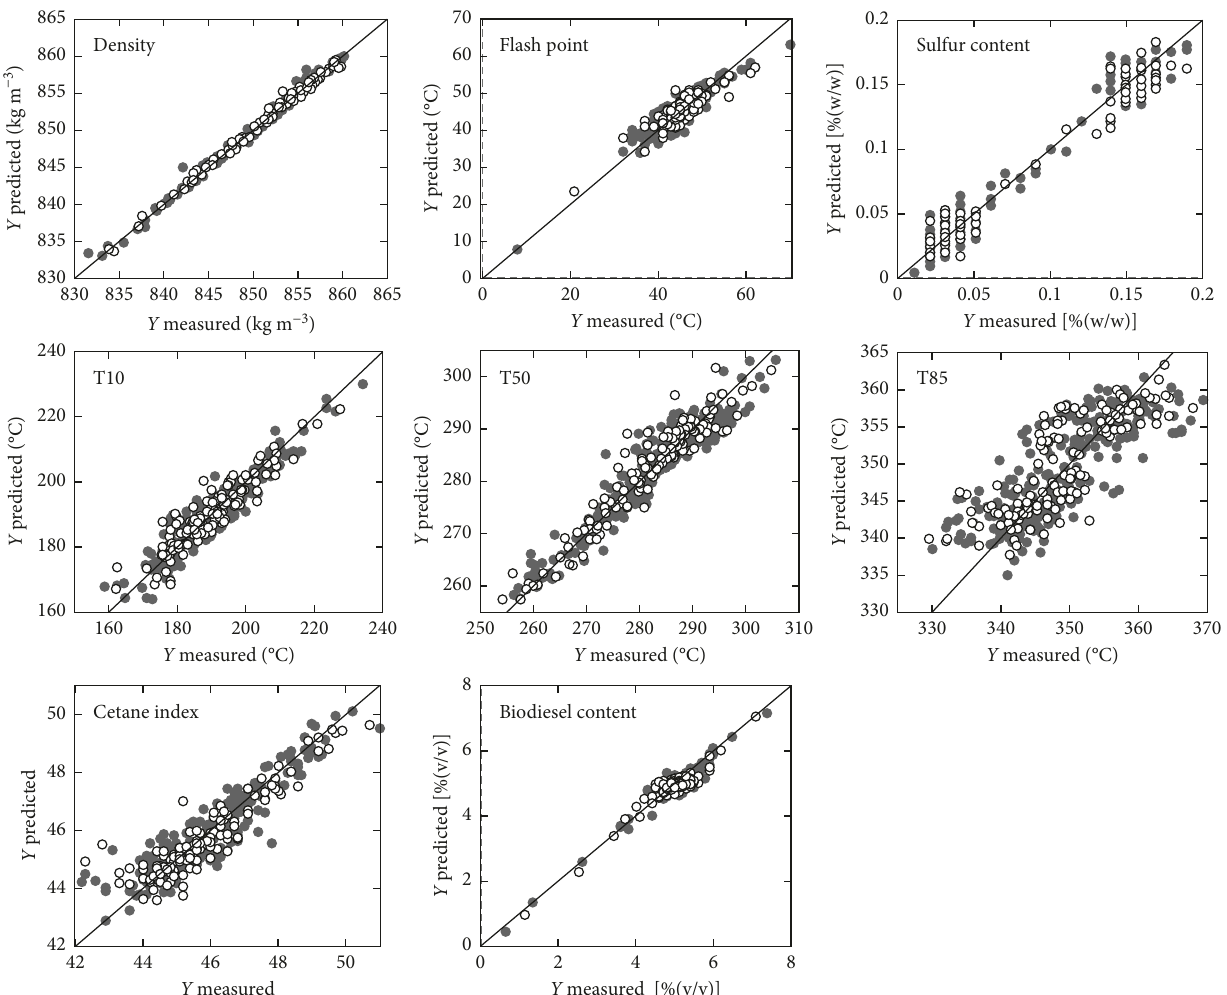
Figure 3: Predicted versus measured value plots of the PLS (Table 7). The complexity of the diesel composition, con- sisting of hundreds of compounds, generates a large amount of information in the FTIR spectra and, therefore, the correlation between the matrix X and the property of in- terest requires a considerable number of LVs. Although the use of OSC reduces the collinearity problem and increases the captured variance of the X and y blocks, several ana- several LVs were required.